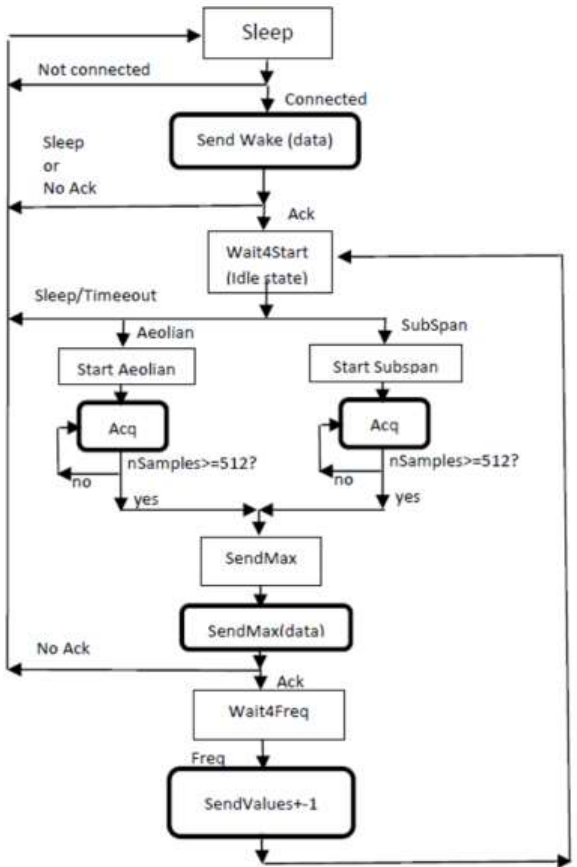
Figure 4. State machine characterizing the WindNode software.